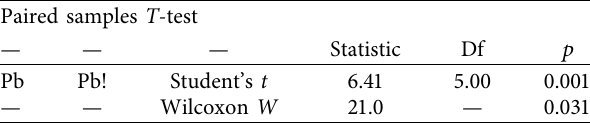
Table 6: Paired samples test. Pb before and after